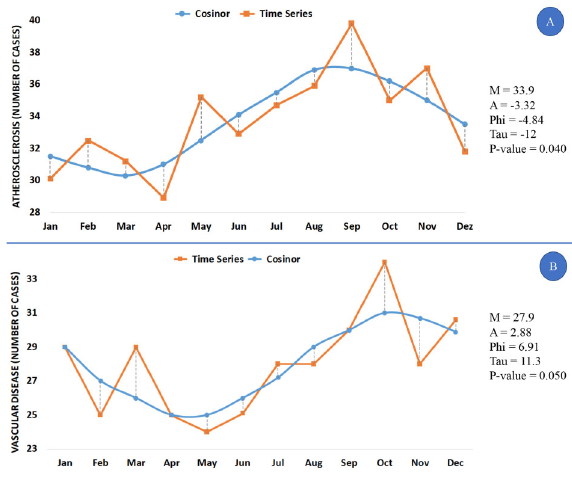
Figure 1. Cosinor analysis for prevalence of outcomes of atherosclerotic cardiovascular hospitalizations in